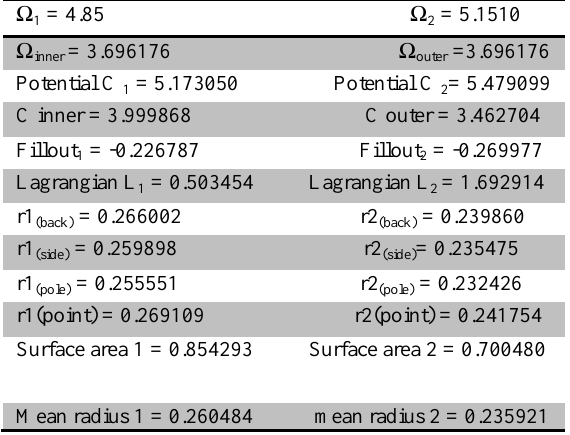
Table6: The output from Binary Maker 3 of binary BH